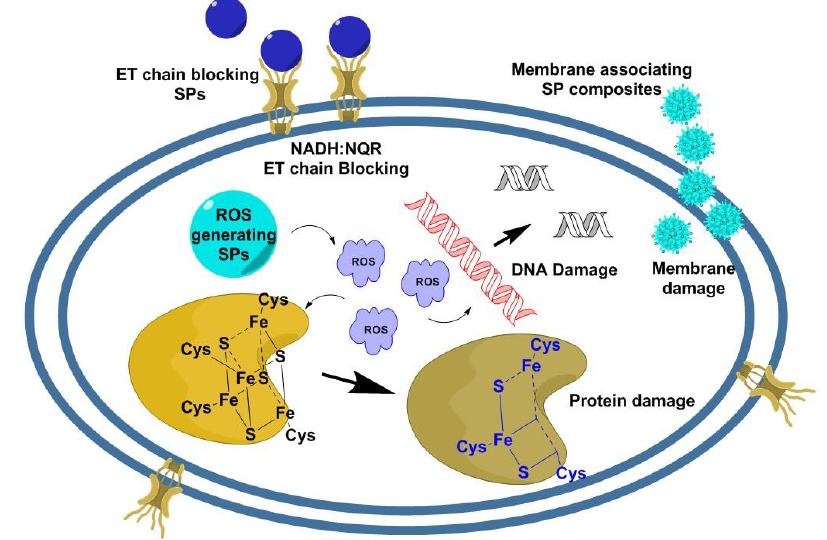
Figure 2. Mechanisms of action of different antibacterial nanocomposite platform (SPs). The various possible paths of bacterial cell killing by the SPs involve: (i) association of the SPs with the bacterial cell membrane via electrostatic or van der Waals interactions, leading to membrane damage; (ii) generation of ROS, leading to bacterial protein, membrane and DNA damage; and (iii) some metal-based SPs can release metal ions that block NADH: NQR electron transport chain [40,56].